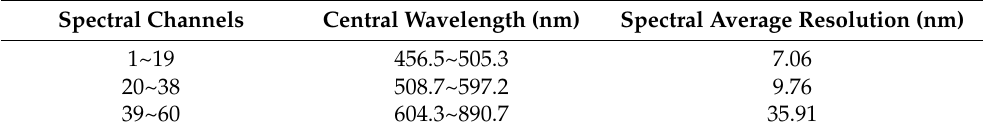
Table 3. Spectral resolution data test table (medium).